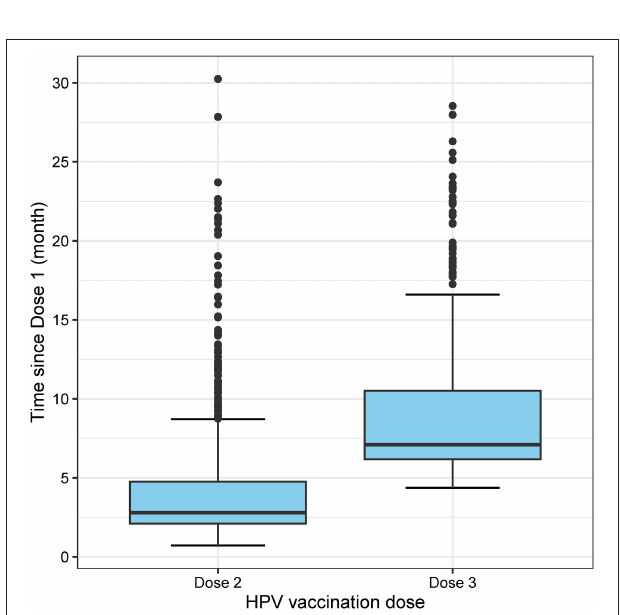
FIGURE 2 | Boxplot showing the time of receiving the second and third dose from the first dose of HPV vaccine.